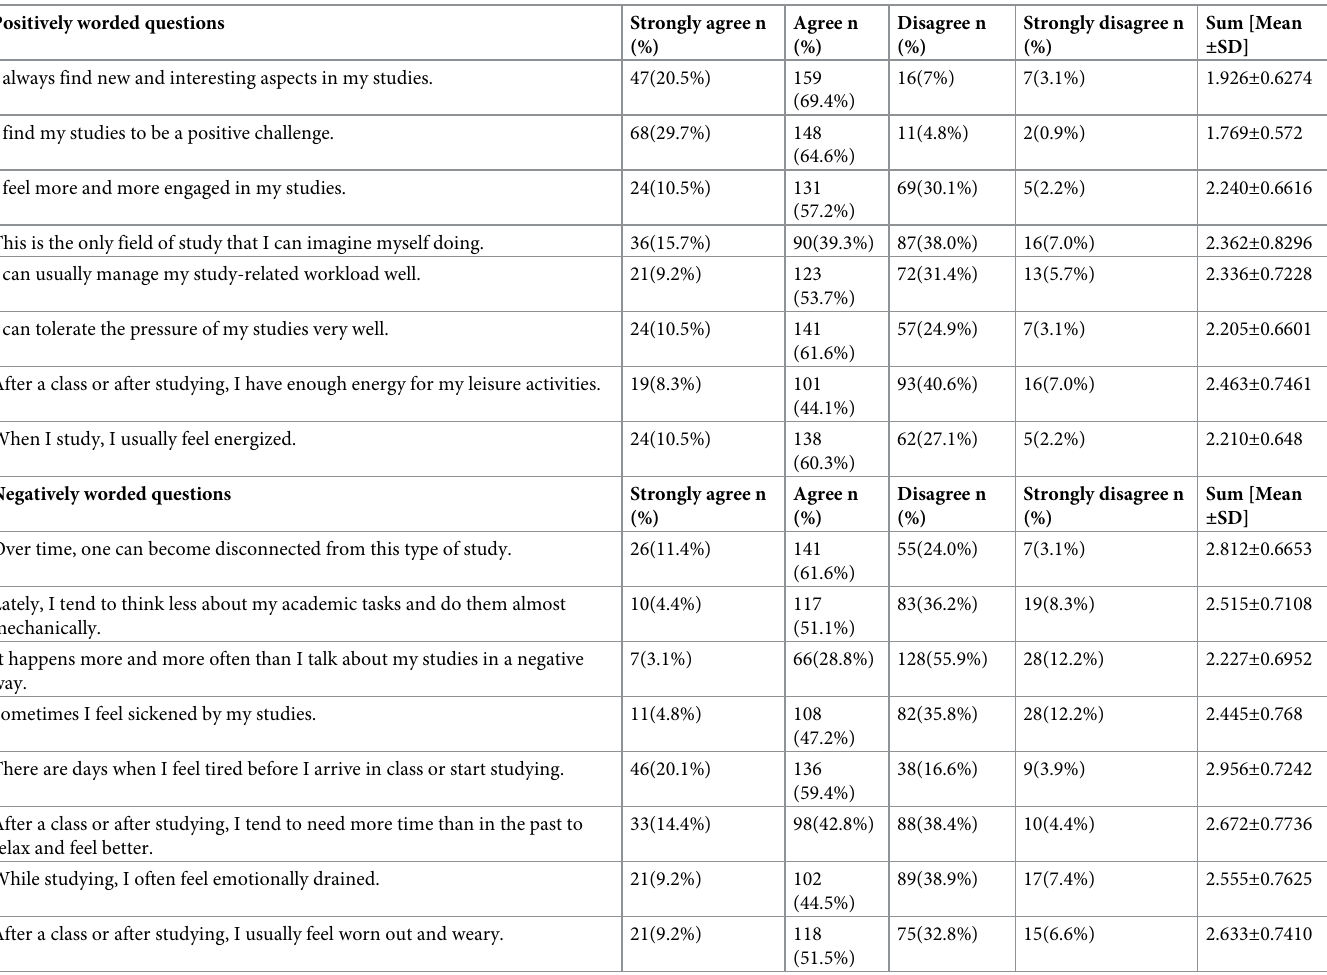
Table 1. Response to individual questions.